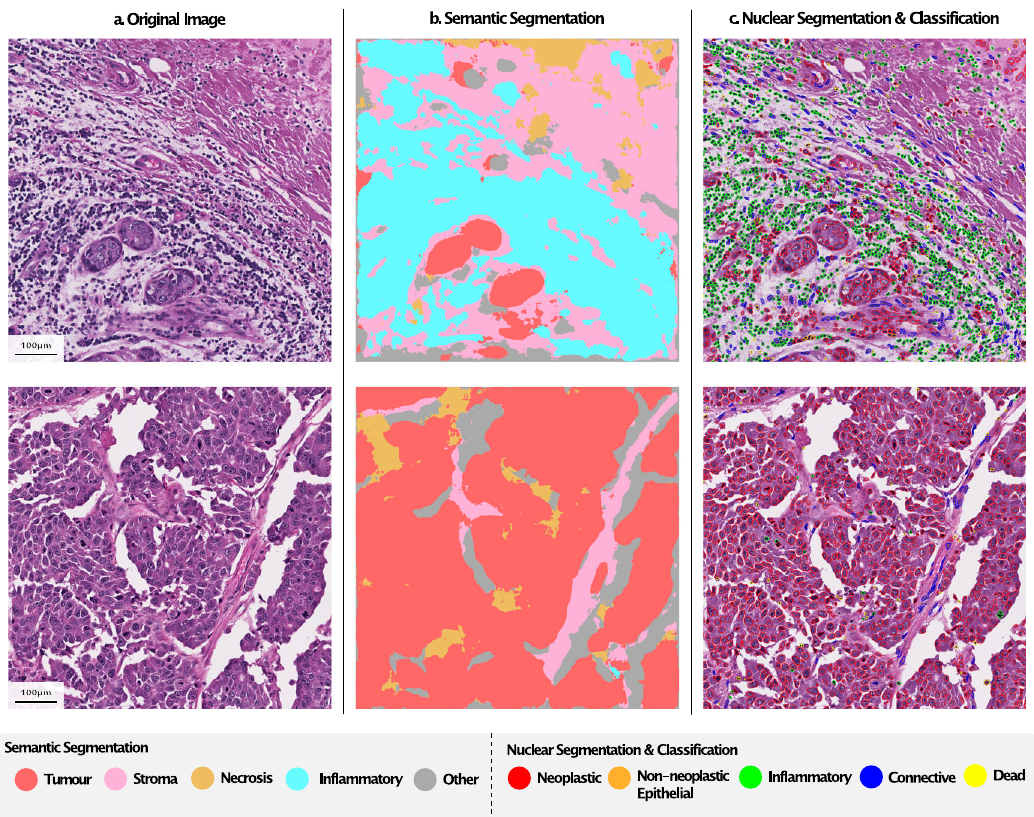
Fig. 3 Illustration of simultaneous tissue Segmentation, nucleus classi fi cation. a H&E stained input visual fi eld. b Semantic segmentation output. c Nucleus instance segmentation and classi fi cation